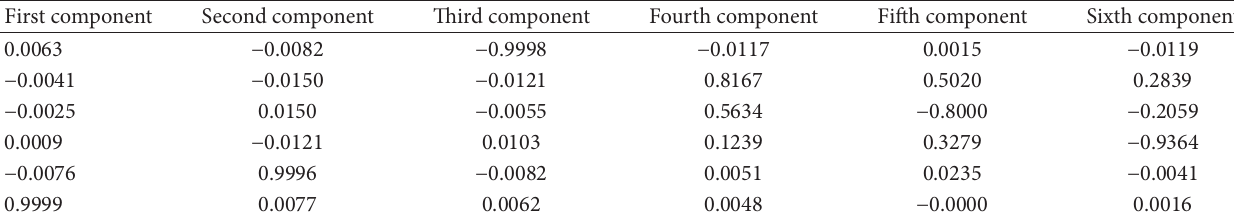
Table 6: Feature vector matrix in Cassini.